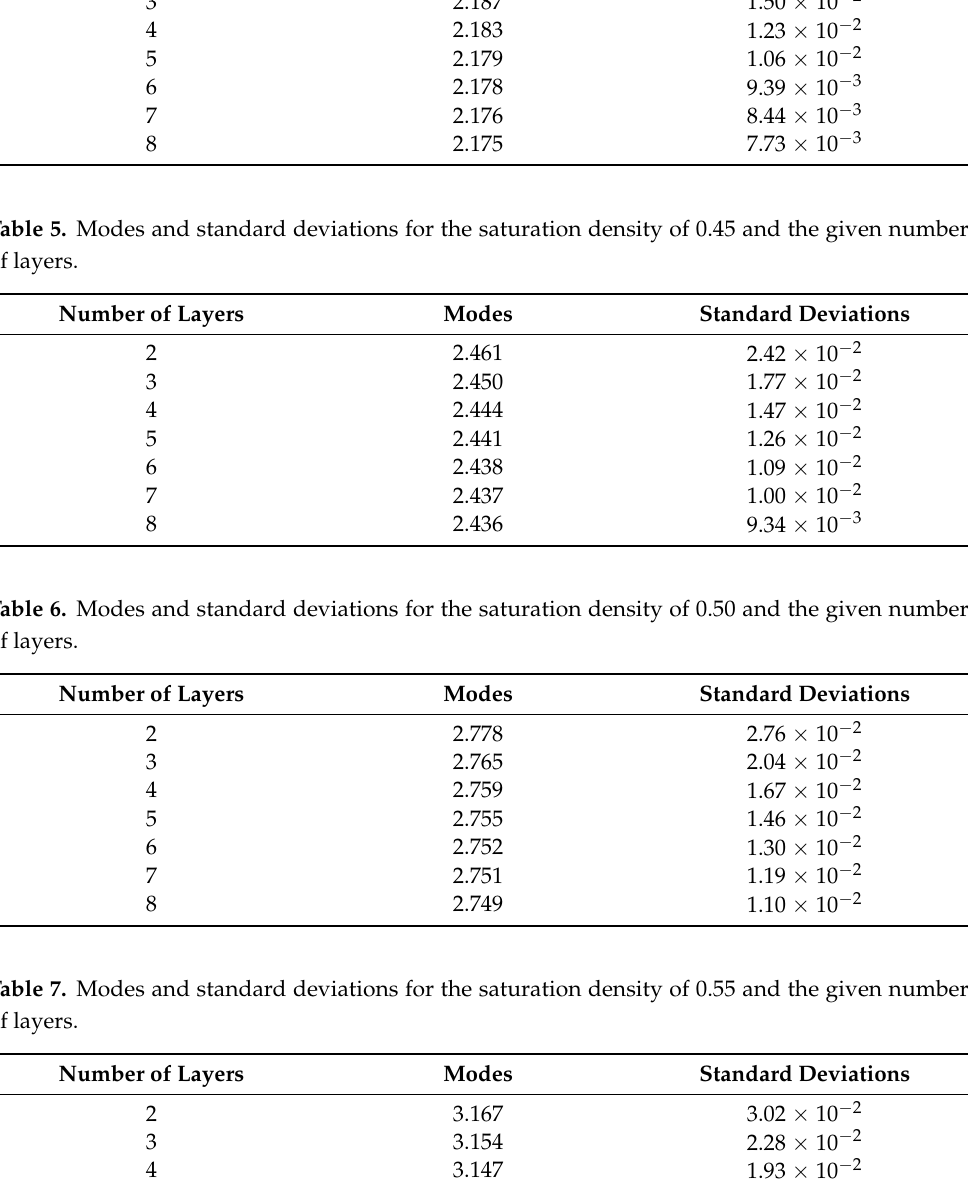
The plot of modes is presented in Figure 9 and the plot of standard deviations is presented in Figure